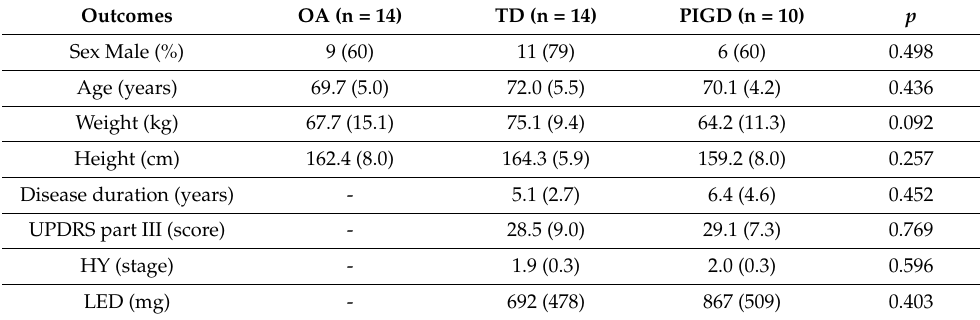
Table 1. Demographic and clinical measures per group. Data are mean (SD) unless stated otherwise.